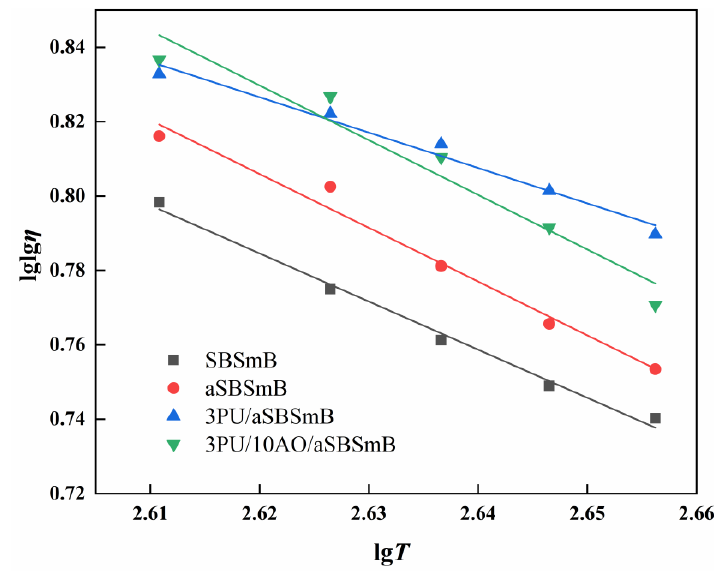
Figure 4. Effect of reaction rejuvenation on the viscosity–temperature characteristic of aSBSmB. Table 3. Viscosity – temperature curve regression analysis.